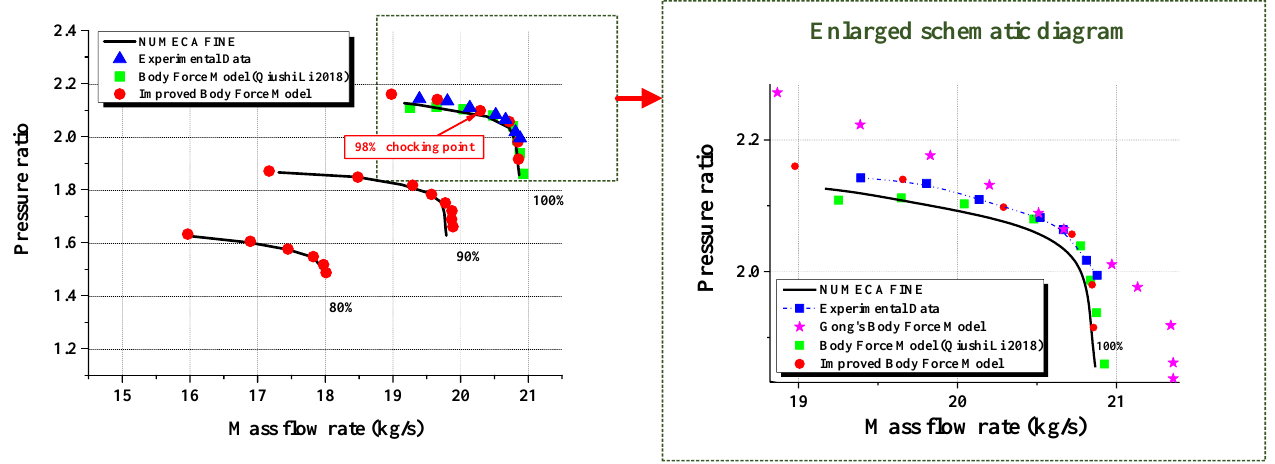
Figure 12. Rotor 37 pressure ratio versus mass flow rate.